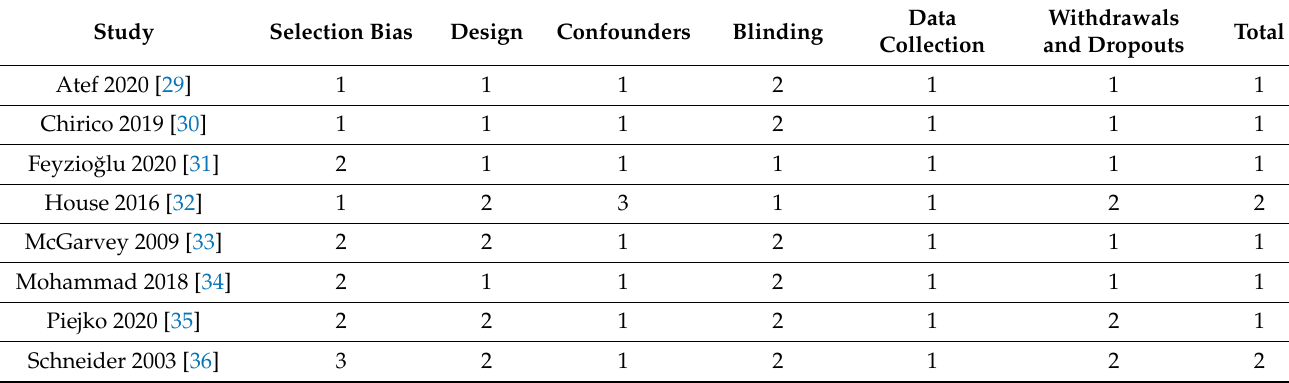
Table 1. The methodological quality of each study using